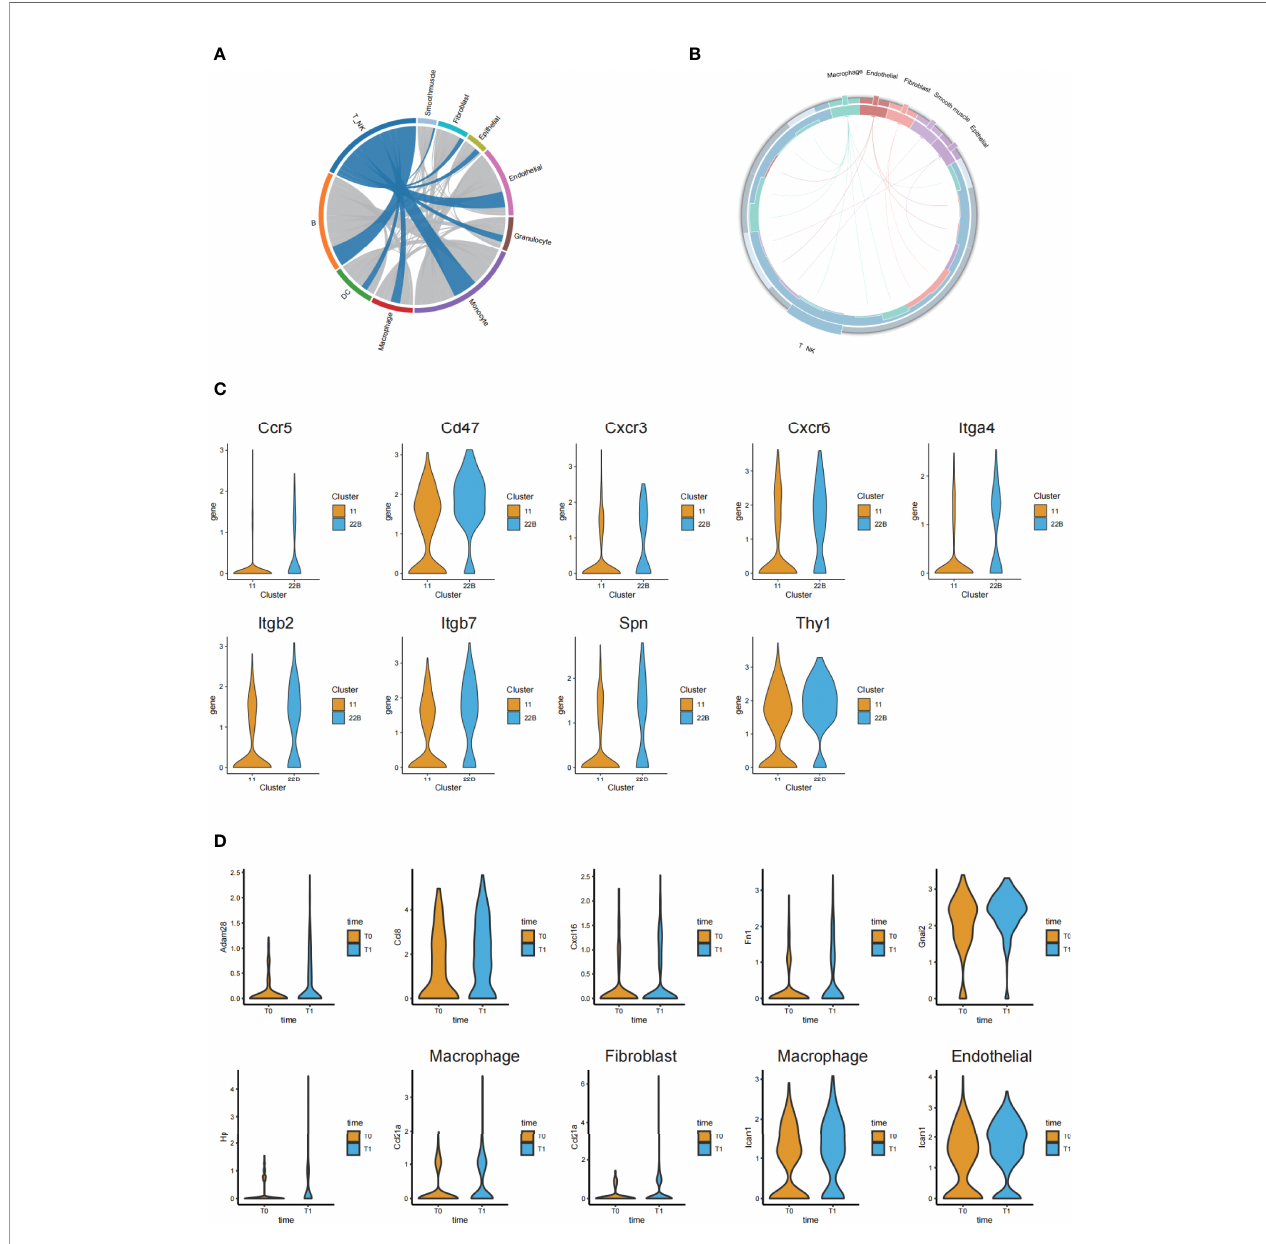
FIGURE 6 | Ligand-receptor-based interaction between immune cells and stromal cells. (A) Circos diagram of the weighted numbers of ligand-receptor interaction pairs between paired interactions of the upregulated genes in different cell types (post-irradiation versus pre-irradiation). (B) Circos diagram showing the 17 upregulated ligand-receptor interactions between the T or NK cells and stromal cells. (C) Violin plots showing the signi fi cantly upregulated receptor genes from the cluster C22B and C11 of T cells. (D) Violin plots of the corresponding and signi fi cantly upregulated ligand genes from other cells after